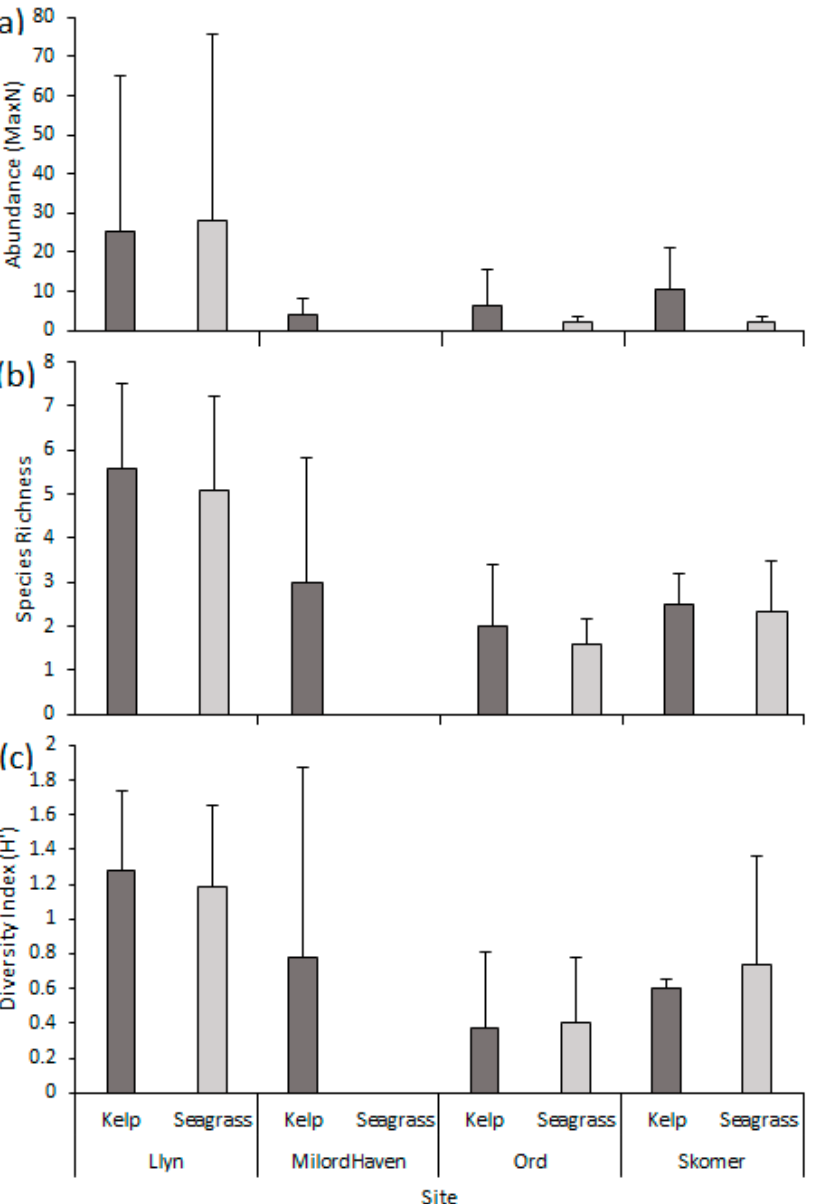
Figure 3. Metric of ( a ) the relative fish abundance (MaxN), ( b ) species richness, and ( c ) Shannon Weiner diversity index (H’) from four seagrass and kelp sites using mono BRUVs in the UK during 2017. Seagrass was not assessed at Milford Haven. Mean data are shown with standard deviation error bars.